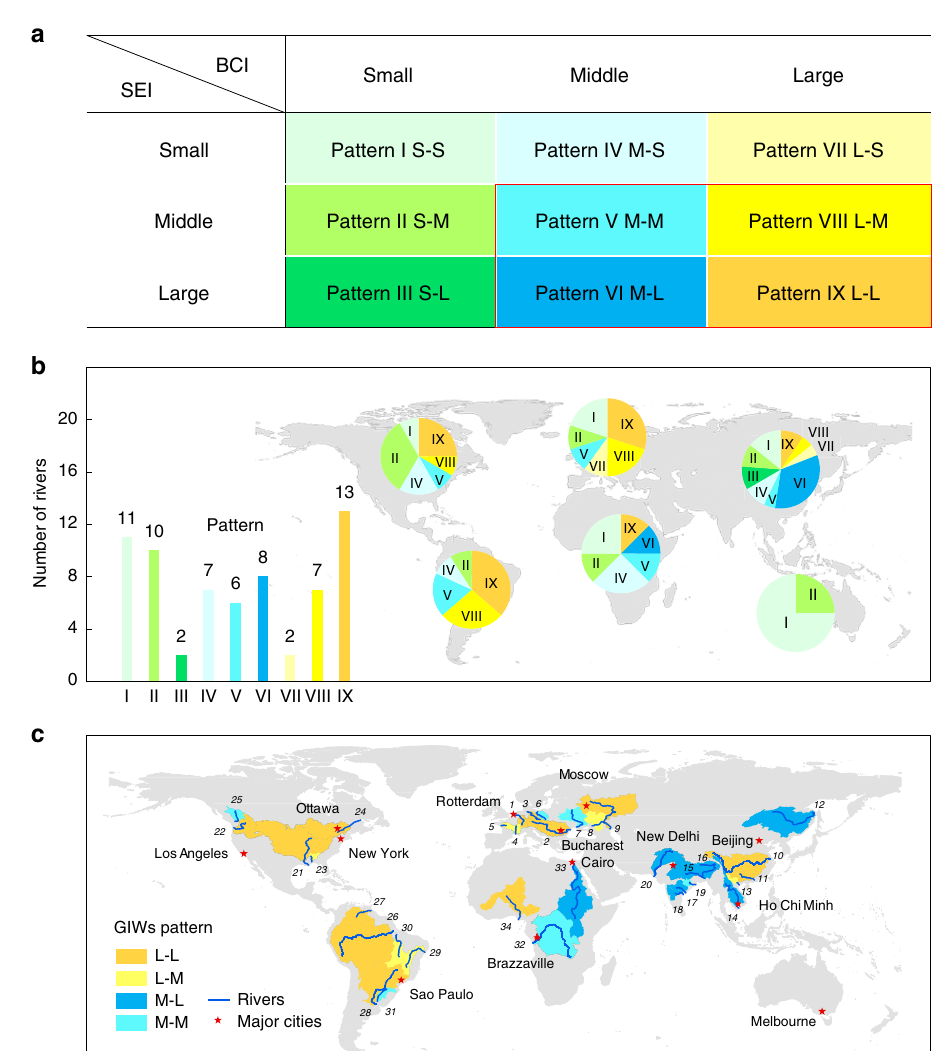
Fig. 2 Identi fi cation and global distribution of Golden Inland Waterways (GIWs). a Nine patterns of inland waterway classi fi ed by bearing capacity index (BCI) and socio-economic index (SEI). BCI and SEI were each divided into three levels (small, S; middle, M; and large, L) at threshold values of 0.33 and 0.67 (for details of the thresholds see Methods). b Numbers of each pattern of inland waterway according to the foregoing pattern classi fi cation system, and their distribution in six continents, obtained for 66 large rivers worldwide. c Map of 34 GIWs, with patterns of M-M, M-L, L-M, and L-L. The GIW numbers marked in ( c ) coincide with those in Supplementary Tables 4 and 5. Source data are provided as a Source Data fi